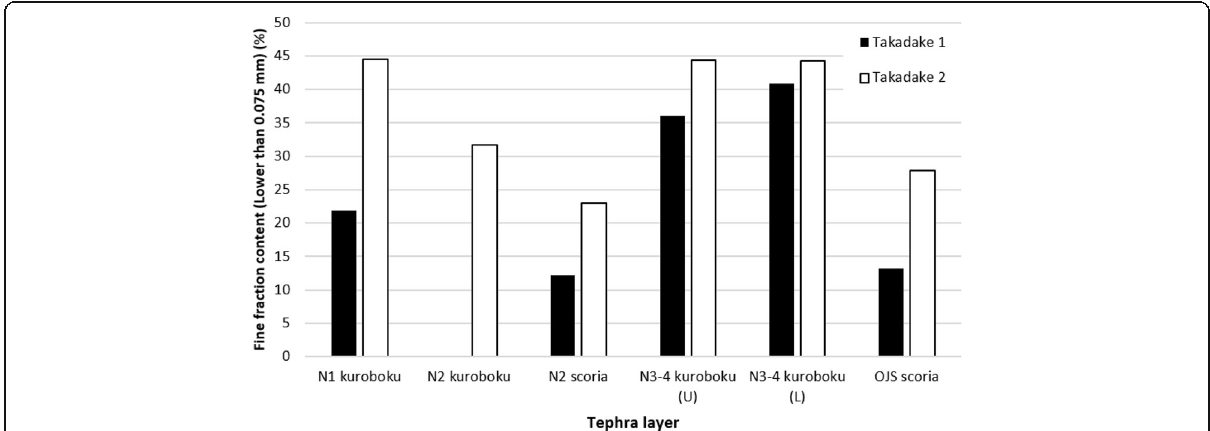
Fig. 4 Fine fraction content on research area shows the dissimilarity between kuroboku and scoria